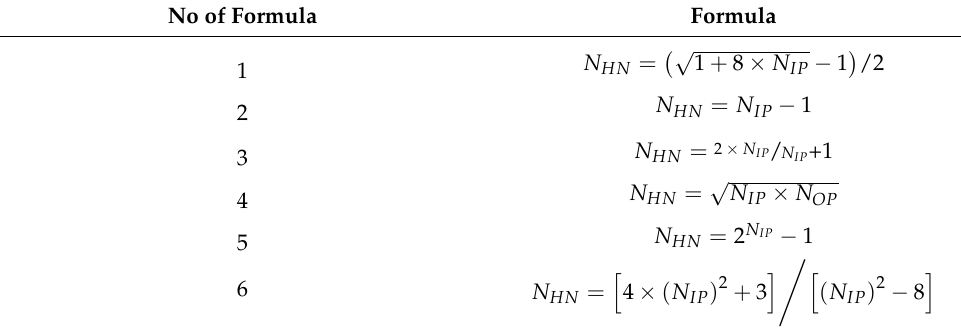
Table 1. The formula for estimating the number of hidden neurons